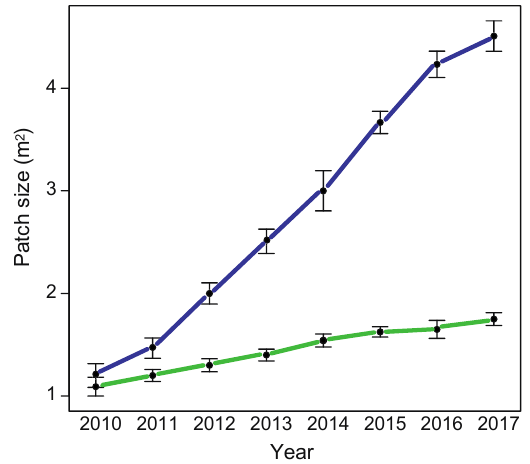
Figure 5. Size of Lamium galeobdolon subsp. argentatum (blue line) and Lamium galeobdolon subsp. galeobdolon (green line) patches (in m 2 ) in 2010–2017. Mean values ± s.e. are shown; n = 6 for both taxa.